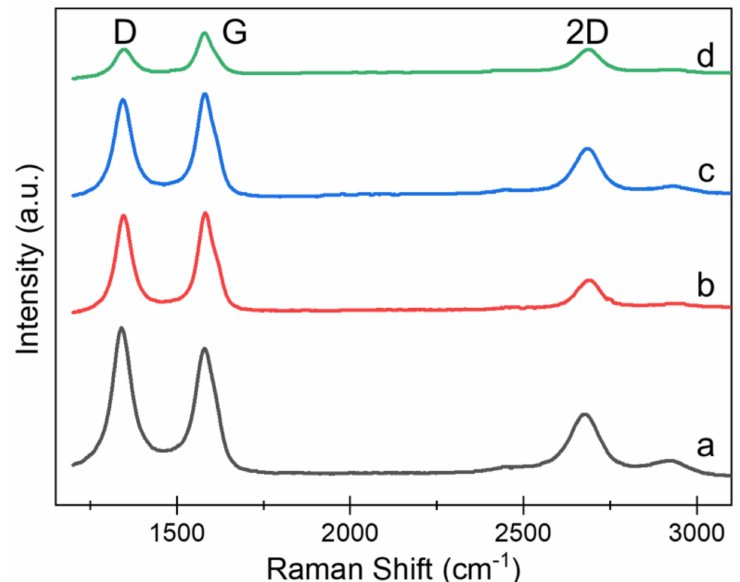
Figure 4. Raman spectra for different laser powers at a speed of 10 cm/s: ( a ) 4.5 W, ( b ) 6.0 W, ( c ) 8.6 W, and ( d ) 9.0 W.